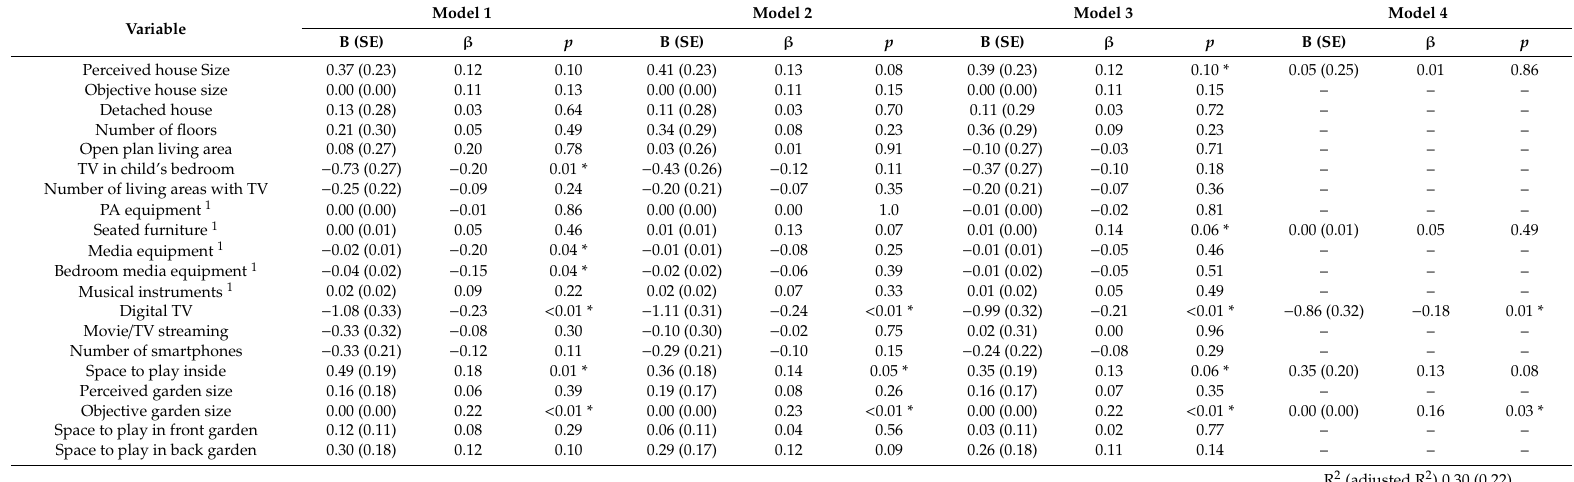
Table 4. Associations between physical home factors and children’s home-based sitting